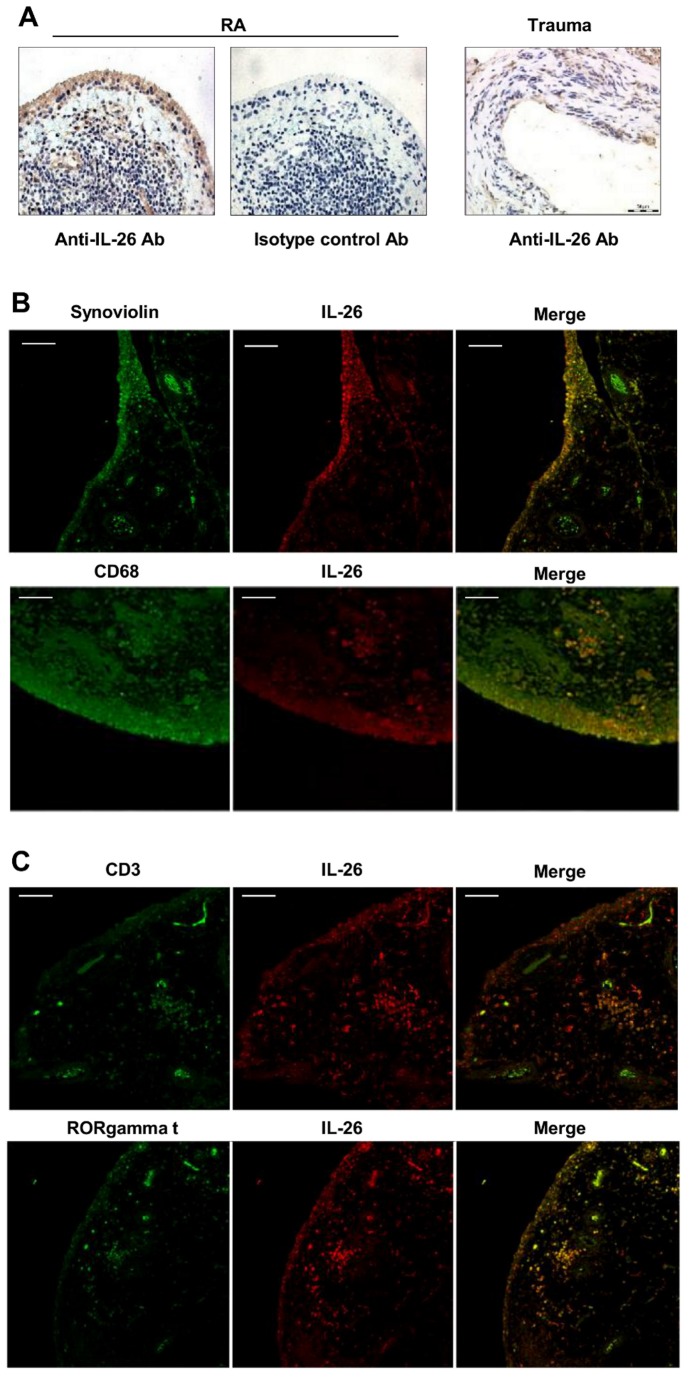
Immunohistological analysis of IL-26 expression in RA synovium.(A) IL-26 expression was analyzed in the synovium of RA patients or trauma patients by immunohistochemistry using an anti-IL-26 mAb (original magnification: ×20). An IgG2b mAb was used as control. Pictures are representative of the results obtained with three RA patients and two patients with recurrent dislocation. (B and C) Immunofluorescence in RA synovium using a biotinylated anti-IL-26 mAb (red) and antibodies directed either against the cell lineage markers (green) CD68 and synoviolin (B), CD3 or RORgamma (C); bars = 100 µm. Pictures are representative of the results obtained with tissues from three RA patients.